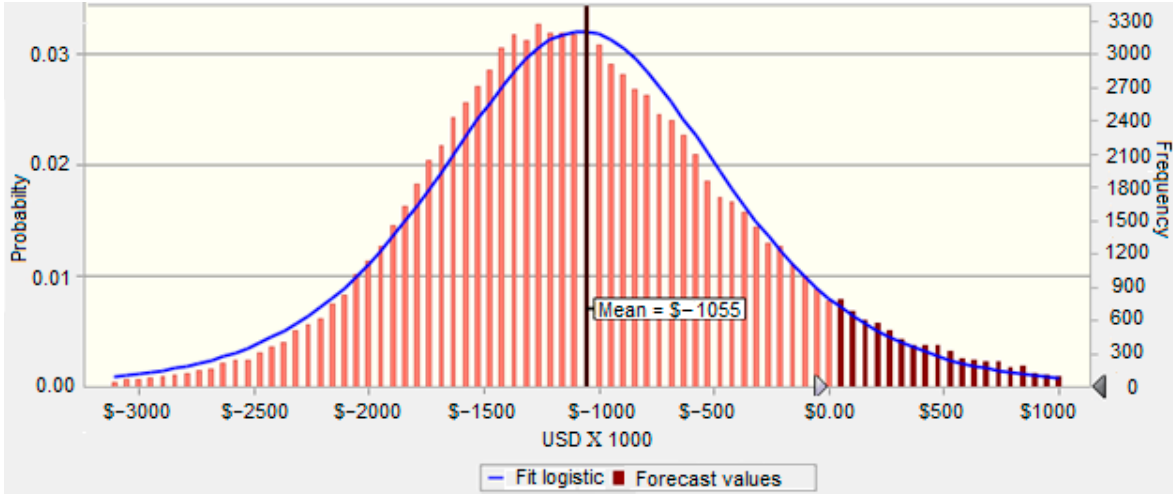
Figure 12. Prediction of NPV behavior for power system based on air as a gasification agent.